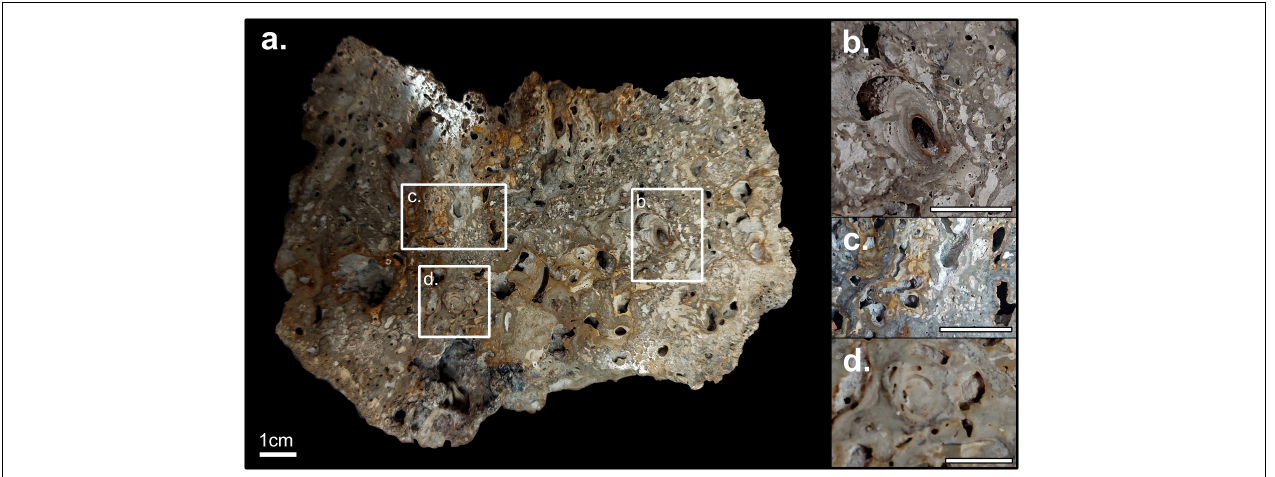
FIGURE 8 | (a) Polished slab of surface crust samples of a mound from the at 90 mbpsl ( Figure 4 ). (b) Coralline algae rounded encrustation. (c) Iron oxide staining. (d) Serpulid. All scale bars are 1